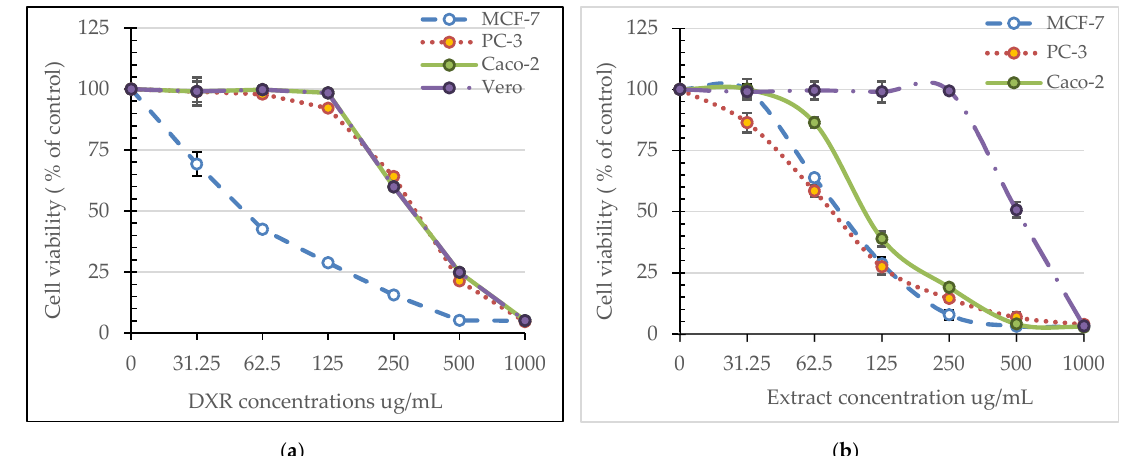
Figure 2. MTT assay results on viability/cytotoxicity of MCF-7, PC-3, Caco-2 and Vero cells: ( a ) effect of A. vulgaris root extract; ( b ) effect of doxorubicin. Values are represented as the mean ( n = 3) ± SD.